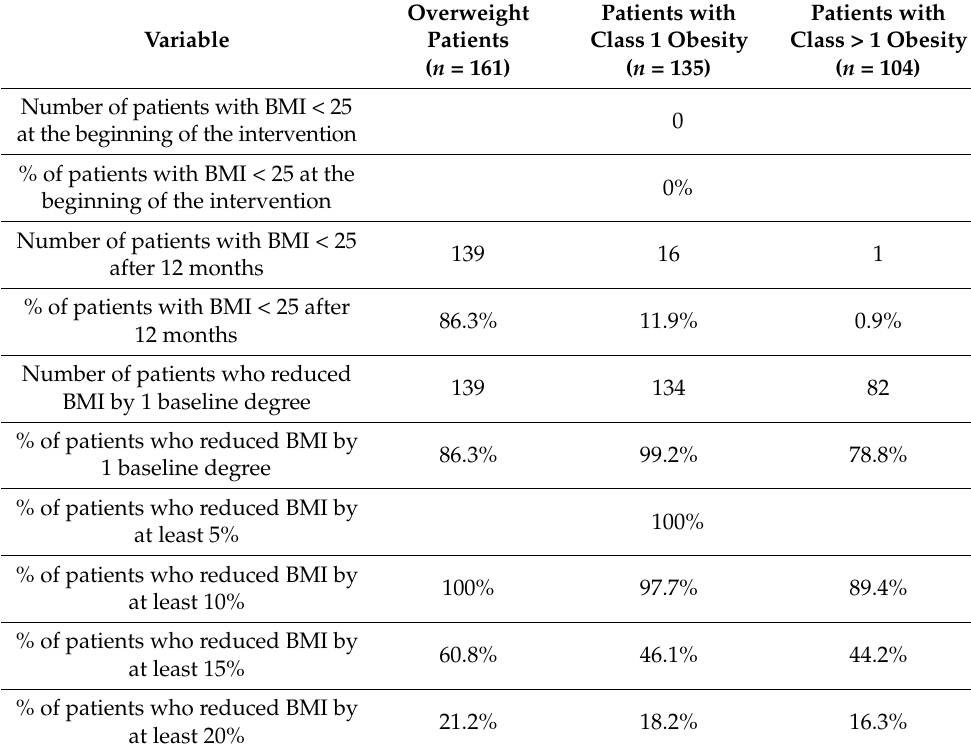
Table 5. Effectiveness of a 12-month weight reduction program as expressed in changes in BMI values. Overweight Variable